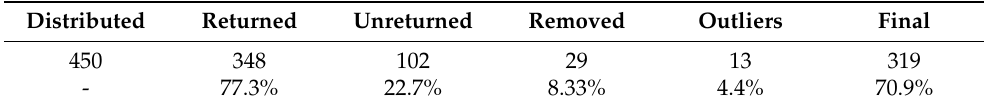
Table 1. Data cleaning, outliers, and response rate.